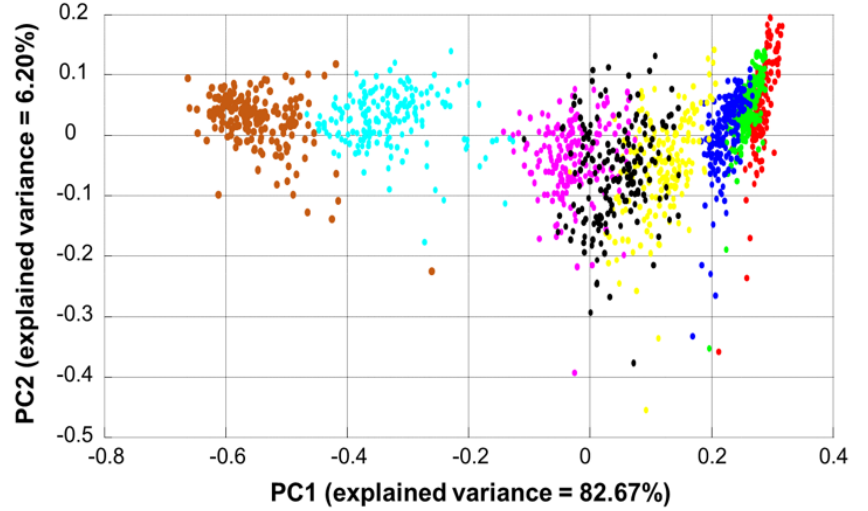
Figure 5. Scatter plot for the first two components obtained from PCA. Red is Raman spectra of control SC (C1), green is C2—0.006 mg resorcinol/mg SC, blue C3—0.008 mg resorcinol/mg SC, yellow C4—0.016 mg resorcinol/mg SC, black is C5—0.028 mg resorcinol/mg SC, magenta is C6—0.054 in turquoise is C7—0.130 mg resorcinol/mg SC, and brown is C8—0.257 mg resorcinol/mg SC.